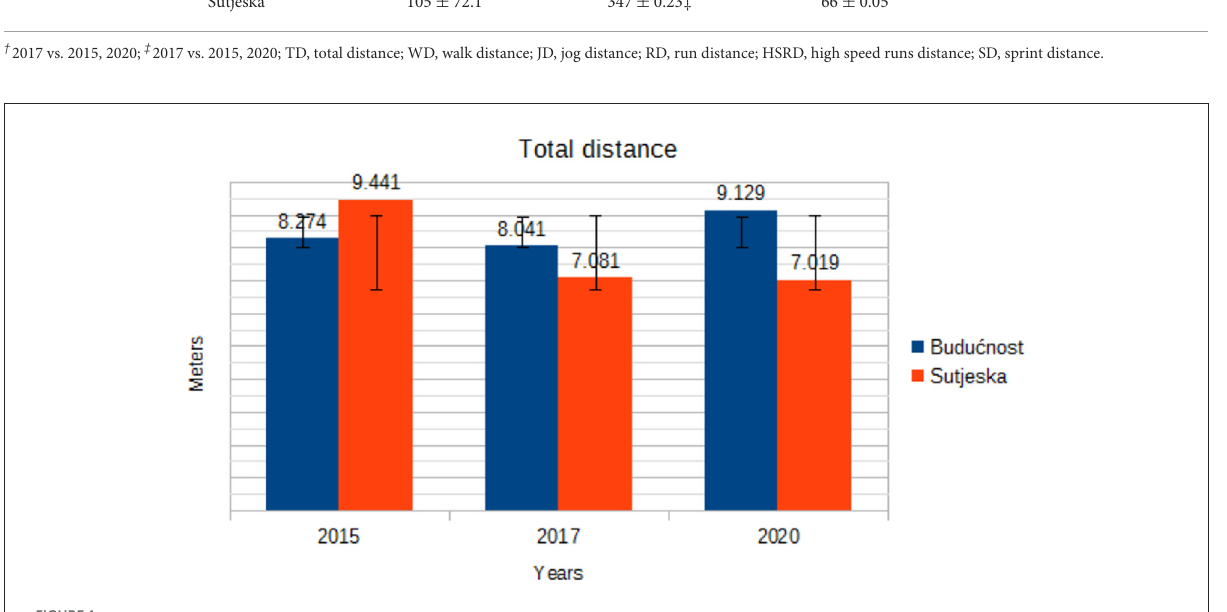
FIGURE1 Trend in mean total distance by